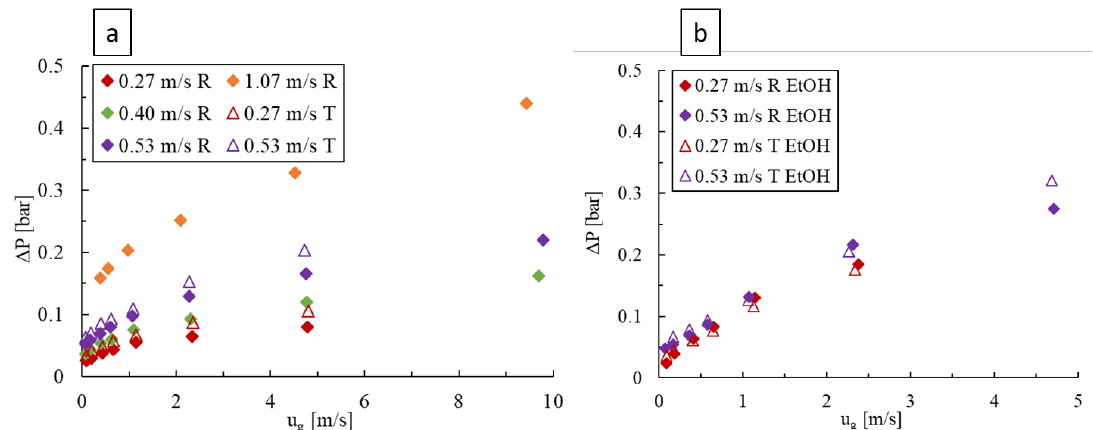
Figure 8. Pressure drop over varying liquid and gas velocities in the LL-Rhombus (R) and LL-Triangle (T) reactors with ( a ) water and ( b ) 0.5 wt% aqueous ethanol as the liquid phase.